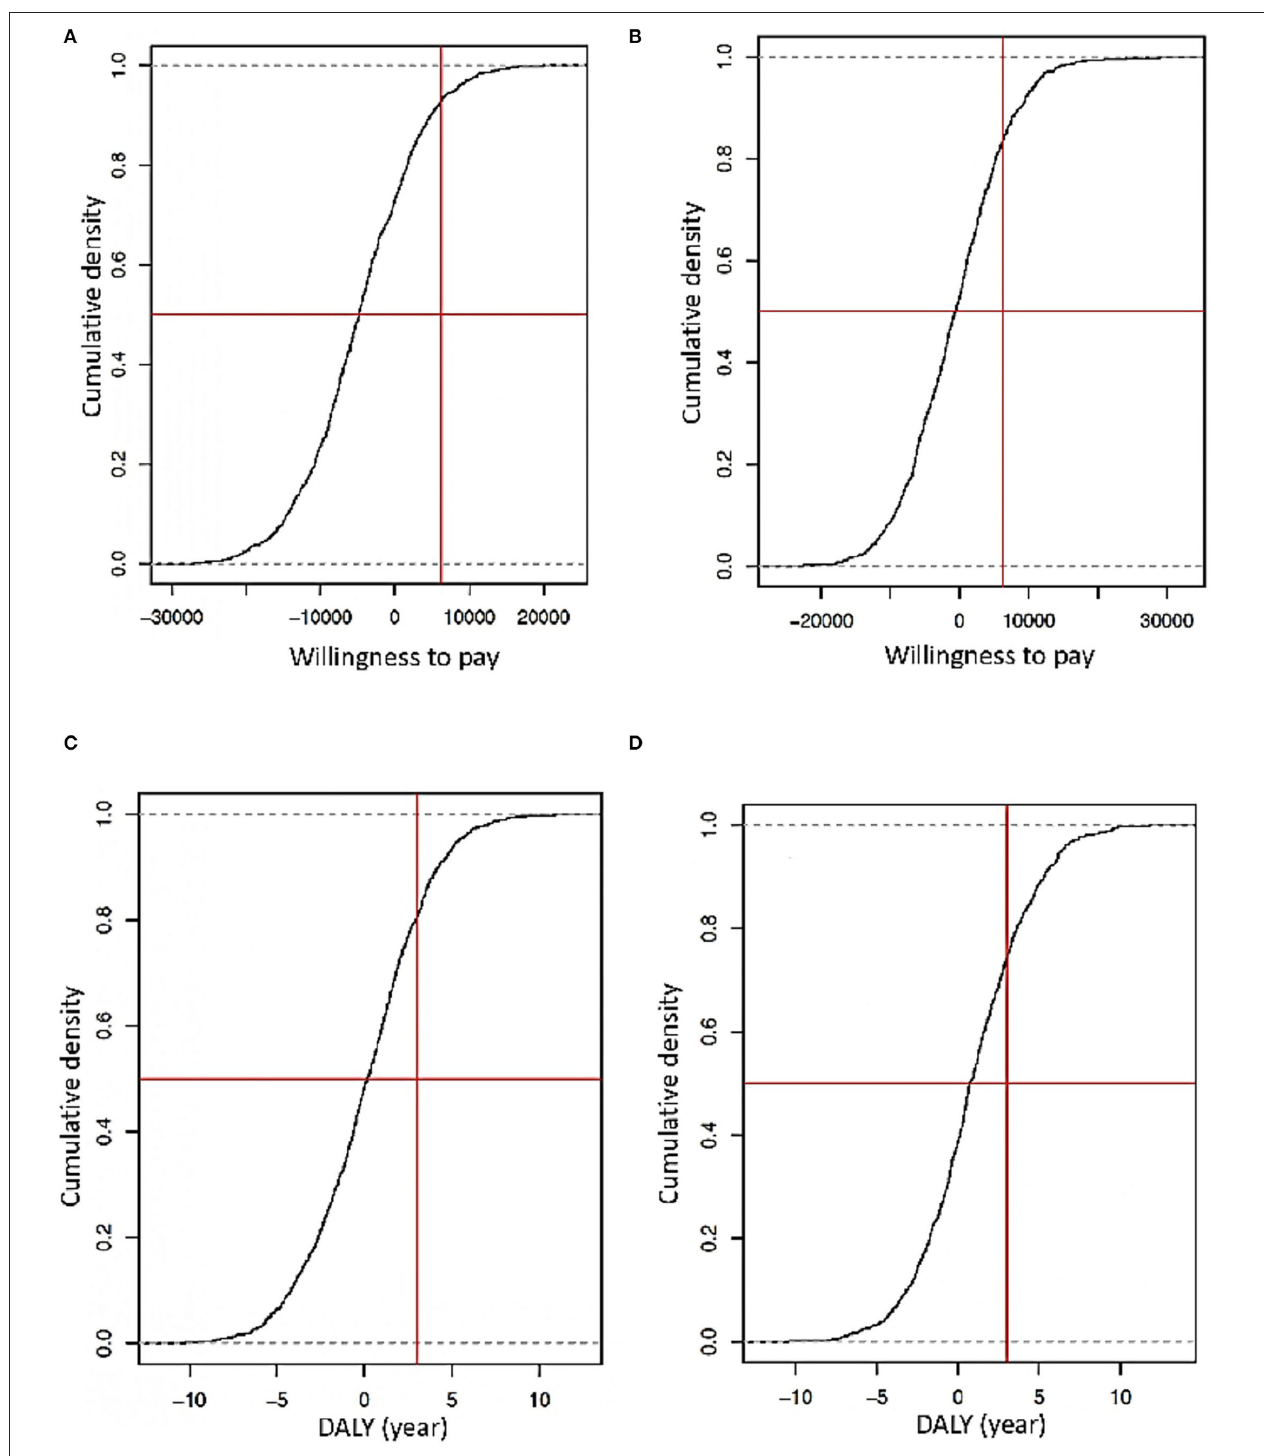
FIGURE 6 | (A) Simulation of the capacity of willingness considering an early screening scenario with deterministic data diagnosis. (B) Simulation of the capacity of willingness considering an early screening scenario with stochastic data diagnosis (the Y is the probability that a spend is accepted how a part of an implemented strategy, X is the capacity of the willingness of an indeterminate government approach concerning GDP that is the vertical red line, and the horizontal red line the threshold of logistic regression of 50%). (C) Simulation of DALYs loss or gained using deterministic data diagnosis. (D) Simulations of DALY’s years gained or loss using stochastic data diagnosis (the Y-axis is the probability to lose or gain years of life by the strategy. The red vertical line represents standard DALYs lost by a late diagnosis, and the horizontal red line is the threshold of logistic regression in 50%).